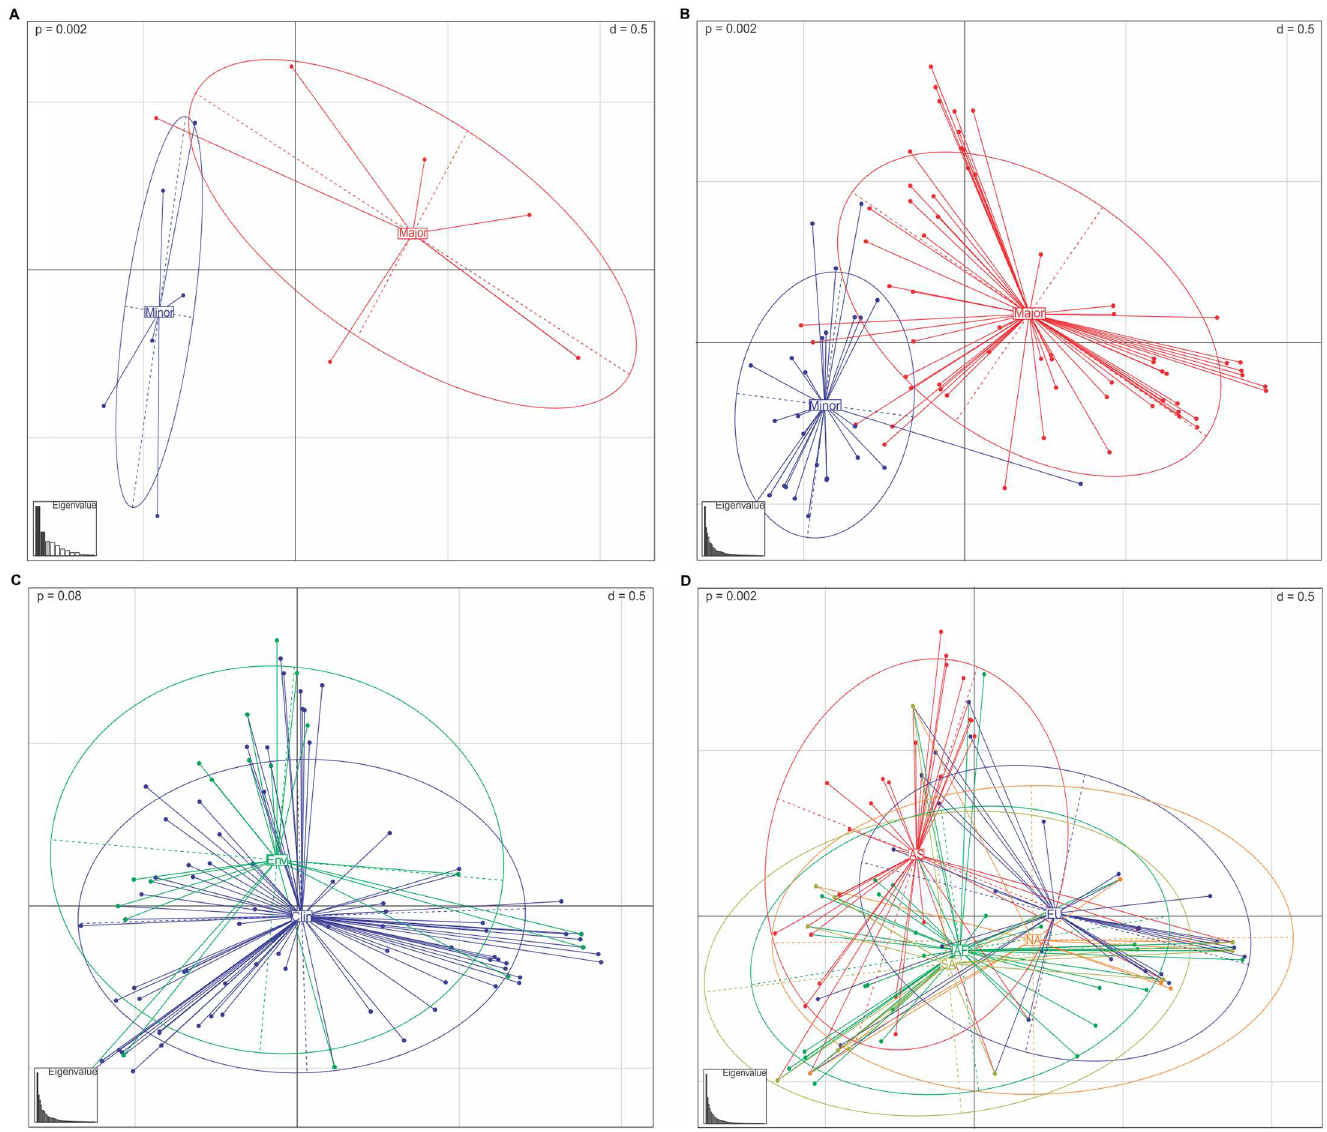
Fig 4. Principle Components Analysis of Cryptococcus neoformans var. grubii VNI allelic profiles depicted according to: A) the southeastern Brazilian population (13 STs), B) C . neoformans population using the global dataset (92 STs), C) isolates distributed according to clinical and environmental sources (104 STs), and D) distributed according to continents (136 STs). Dots represent STs linked by coloured lines to form clusters, proportional in sizes to the number of isolates. The two main clusters identifiedin the C . neoformans populationare highlightedin blue (minor) and red (major). The samples recoveredfrom clinical (Clin) and environmental (Env) sources are highlighted in blue and green respectively.The colours of each continentof origin are describedas follows: blue: Europe (EU), brown: South America (SA), green: Africa (AF), orange: North America (NA), red: Asia (AS). Eigenvalues highlightingthe two first components are representedin the bar plot. The p-value calculatedusing the Mont Carlo test is described in the upper left side.